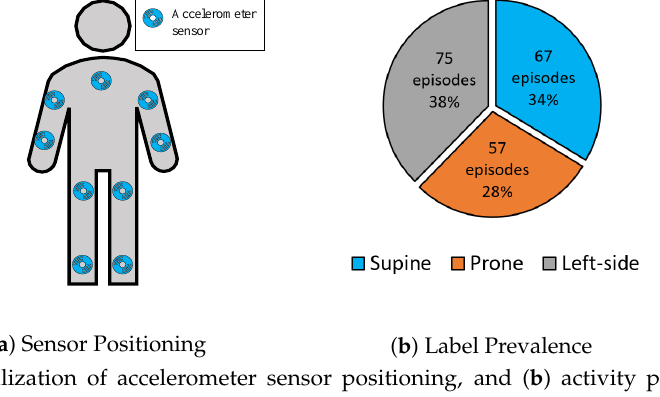
Figure 2. ( a ) Visualization of accelerometer sensor positioning, and ( b ) activity prevalence for Class-Act